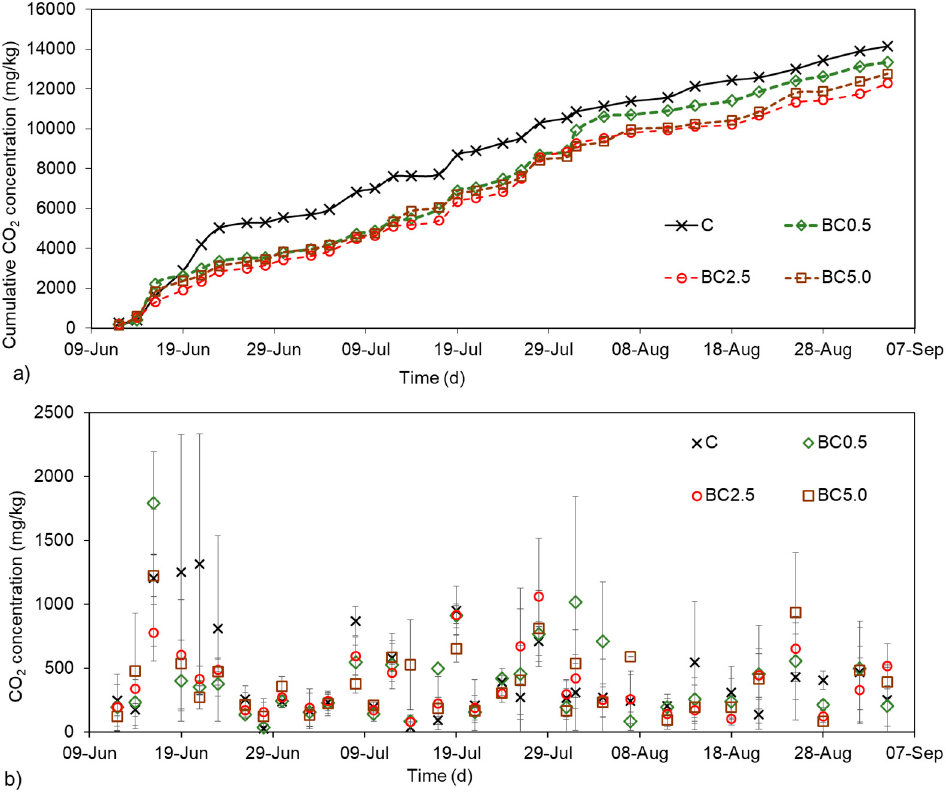
Figure 7. Soil respiration changes as ( a ) cumulative and ( b ) discrete data of measured CO 2 concentrations (mg/kg) over time between the different biochar added treatments, based on 33 measurement points. n = 3; ±SD.